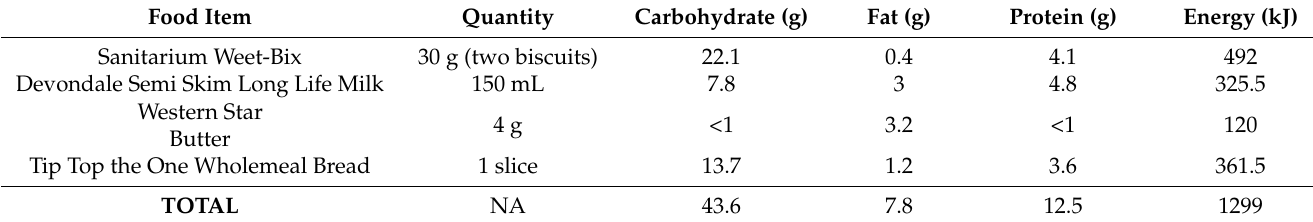
Table 1. Macronutrient composition of the standard breakfast provided to participants during the controlled period. Food Item Quantity Carbohydrate (g) Fat (g) Protein (g) Energy (kJ) Sanitarium Weet-Bix 30 g (two biscuits) 22.1 Devondale Semi Skim Long Life Milk 150